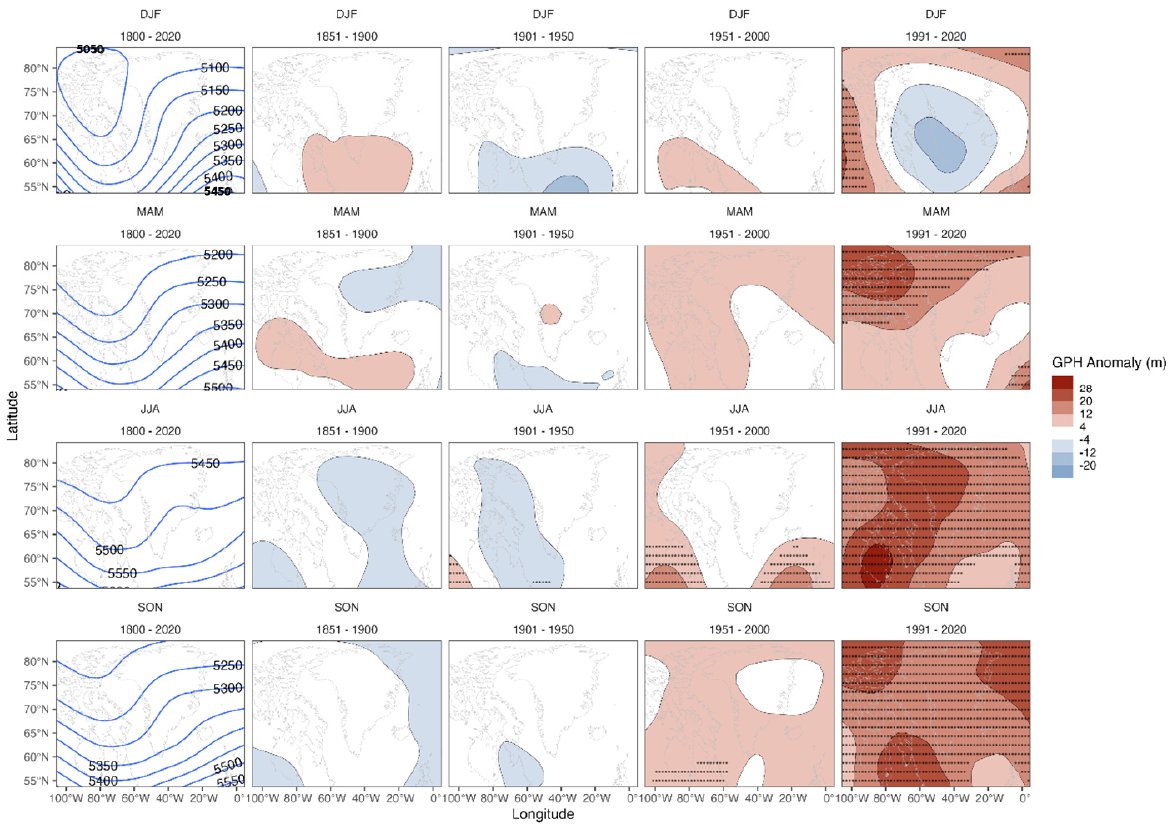
Figure 1. Seasonal mean conditions for 1800–2020 ( left column ) and anomalies for various periods (with respect to 1800–2020) of the spatial pattern of 500 geopotential height over the Greenland region for different periods based on our spliced EKF400v2–ERA5 series for ( top to bottom ) winter (DJF), spring (MAM), summer (JJA) and autumn (SON). The stippling shows areas of significant ( p ≤ 0.05) anomalies where the geopotential height anomaly is ≥ ±4 m.